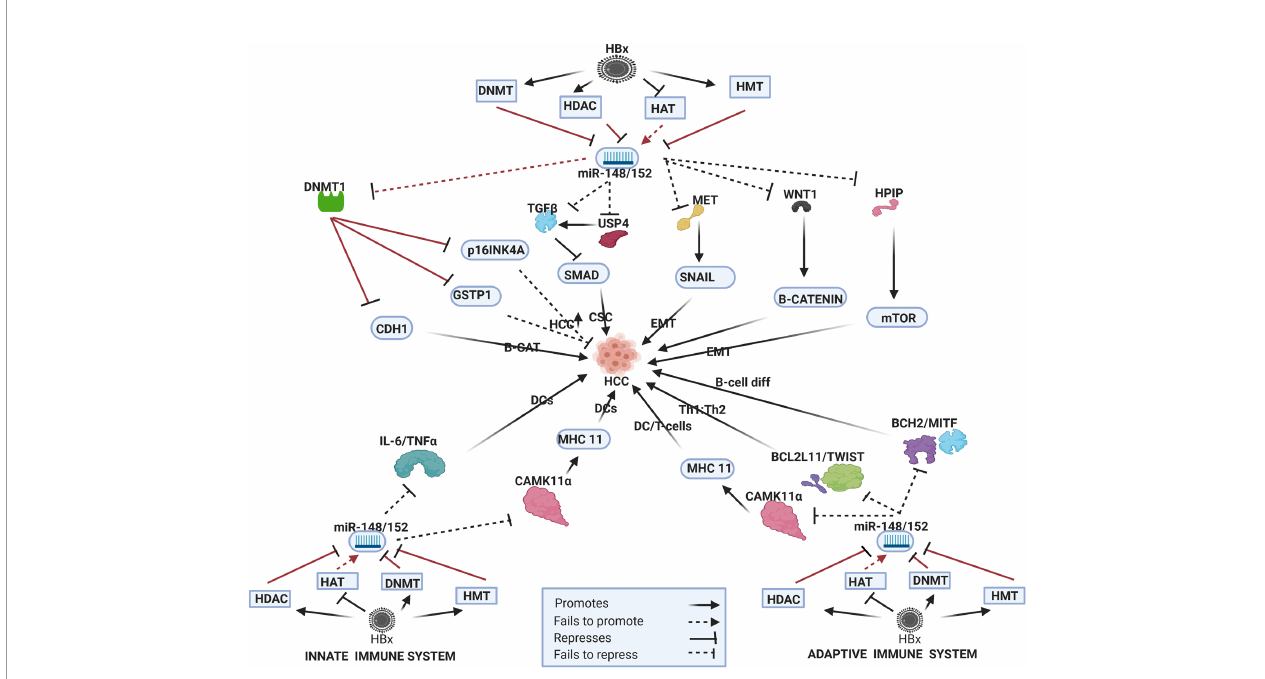
FIGURE 4 | Epi-miR-148/152 in HBV-HCC and immune pathways. HDAC-Histone deacetylation, HAT-histone acetylation, DNMT-DNA methylation, HMT-Histone methylation (pathways in dark red involve identi fi ed direct upstream or downstream epigenetic proteins/enzymes). HBx protein can downregulate or initiate HDAC/ HAT/DNMT/HMT to repress miR-148/152 modulation in various HBV-HCC pathways including WNT-B-CATENIN, TP53, and AKT/mTOR to in fl uence HCC pathogenesis. HBx epigenetically downregulated miR-148/152 also regulates DC expression in the innate immune system, as well as T-cell and B-cell expression in the adaptive immune